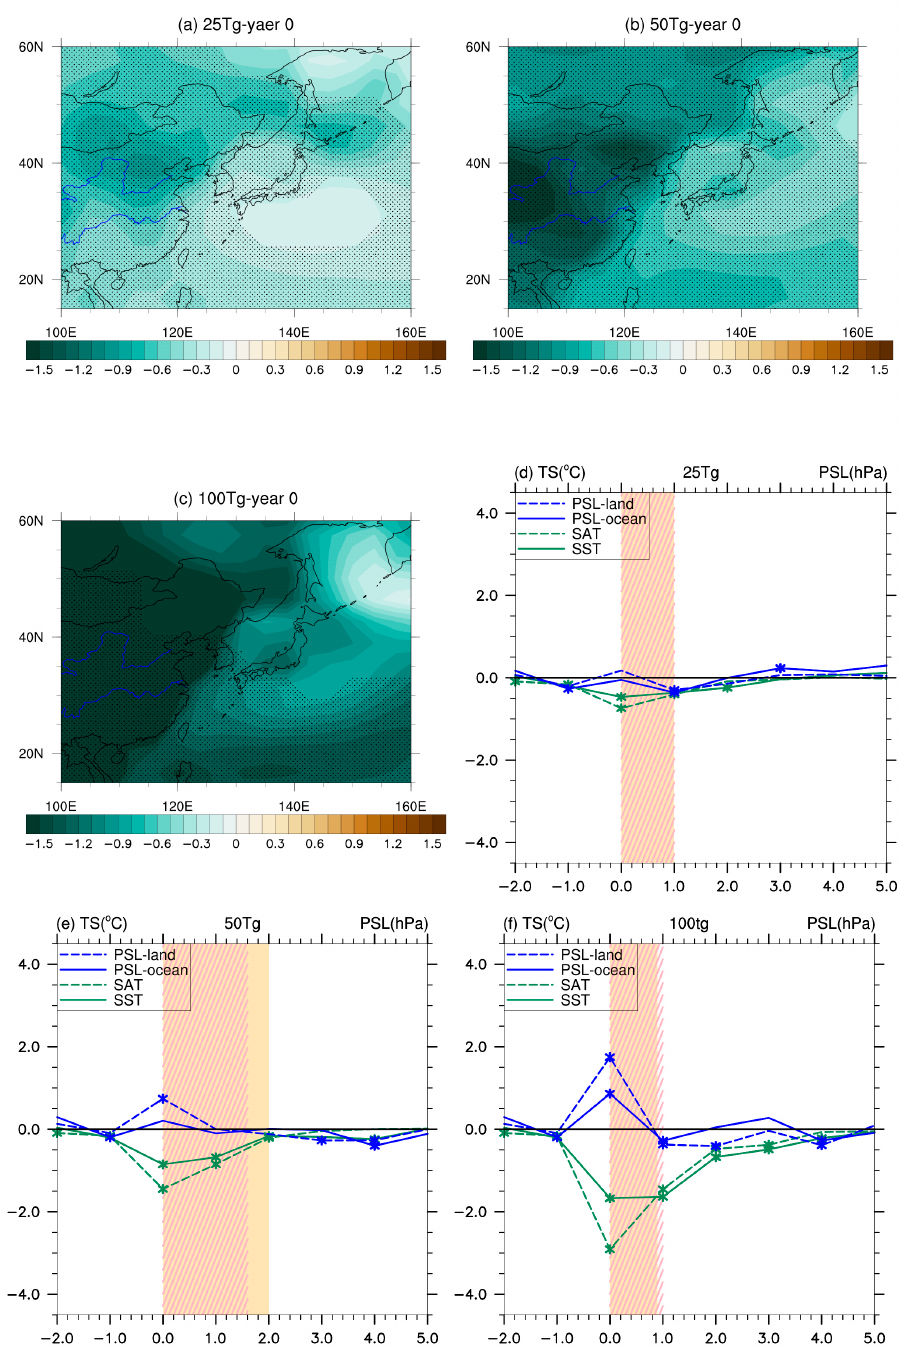
Figure 5. ( a )–( c ) The summer (May–September) surface temperature (unit: °C) in the year of volcanic eruptions with magnitudes of 25 Tg, 50 Tg and 100 Tg, respectively. ( d )–( f ) The regional mean surface temperature (SAT; green dashed line; unit: °C) over Eastern China (20–50° N, 90–120° E), the surface temperature (SST; green solid line; unit: °C) over China’s eastern coastal area (20–50° N, 120–150° E), the sea level pressure (SLP) anomalies over Eastern China (blue solid line; unit: hPa) and surrounding oceans (blue dashed line; unit: hPa) in the volcanic sensitivity experiment with magnitudes of 25 Tg, 50 Tg and 100 Tg, respectively. The pink shaded area covers the time period when land-SLP is higher than the ocean-SLP after a volcanic eruption. The yellow shaded area covers the time period when decreases of the SAT are larger than decreases of the SST; * indicates that the result is significant based on the Student t-test.